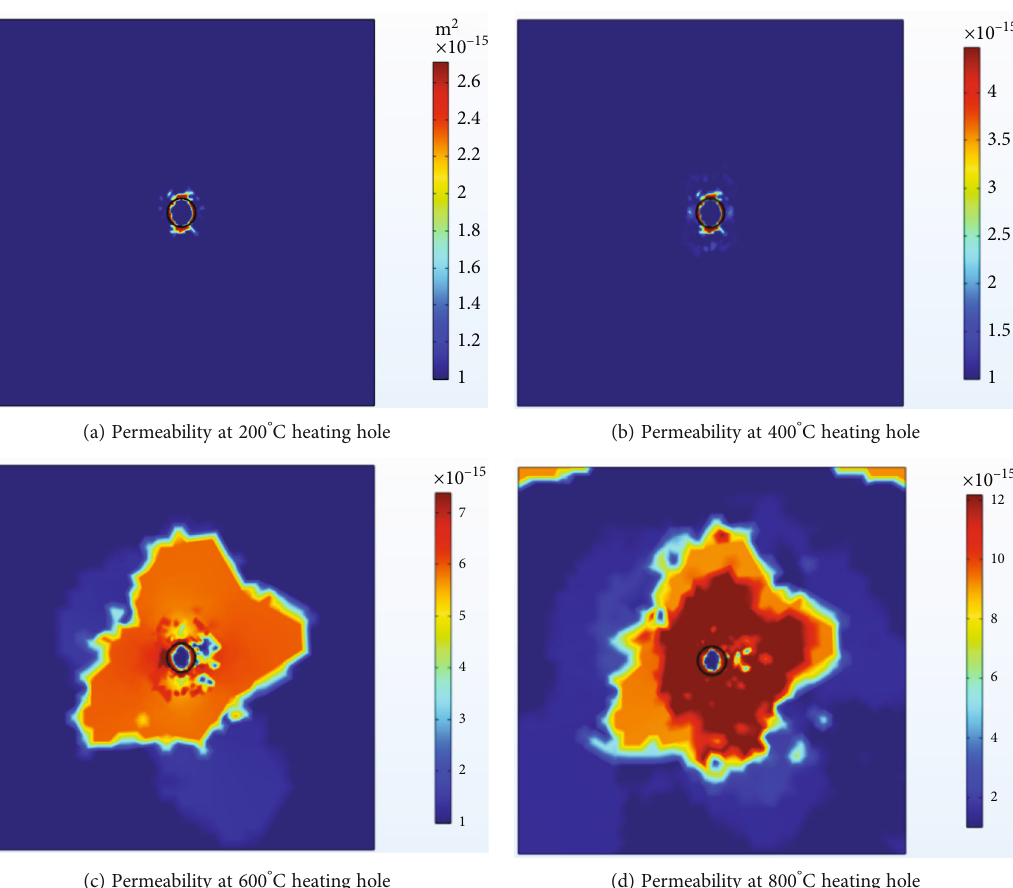
Figure 4: Coal body permeability under di ff erent heating